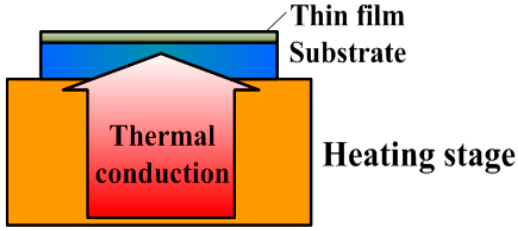
Figure 2. Schematic diagram of thermal conduction between the thin film and substrate.